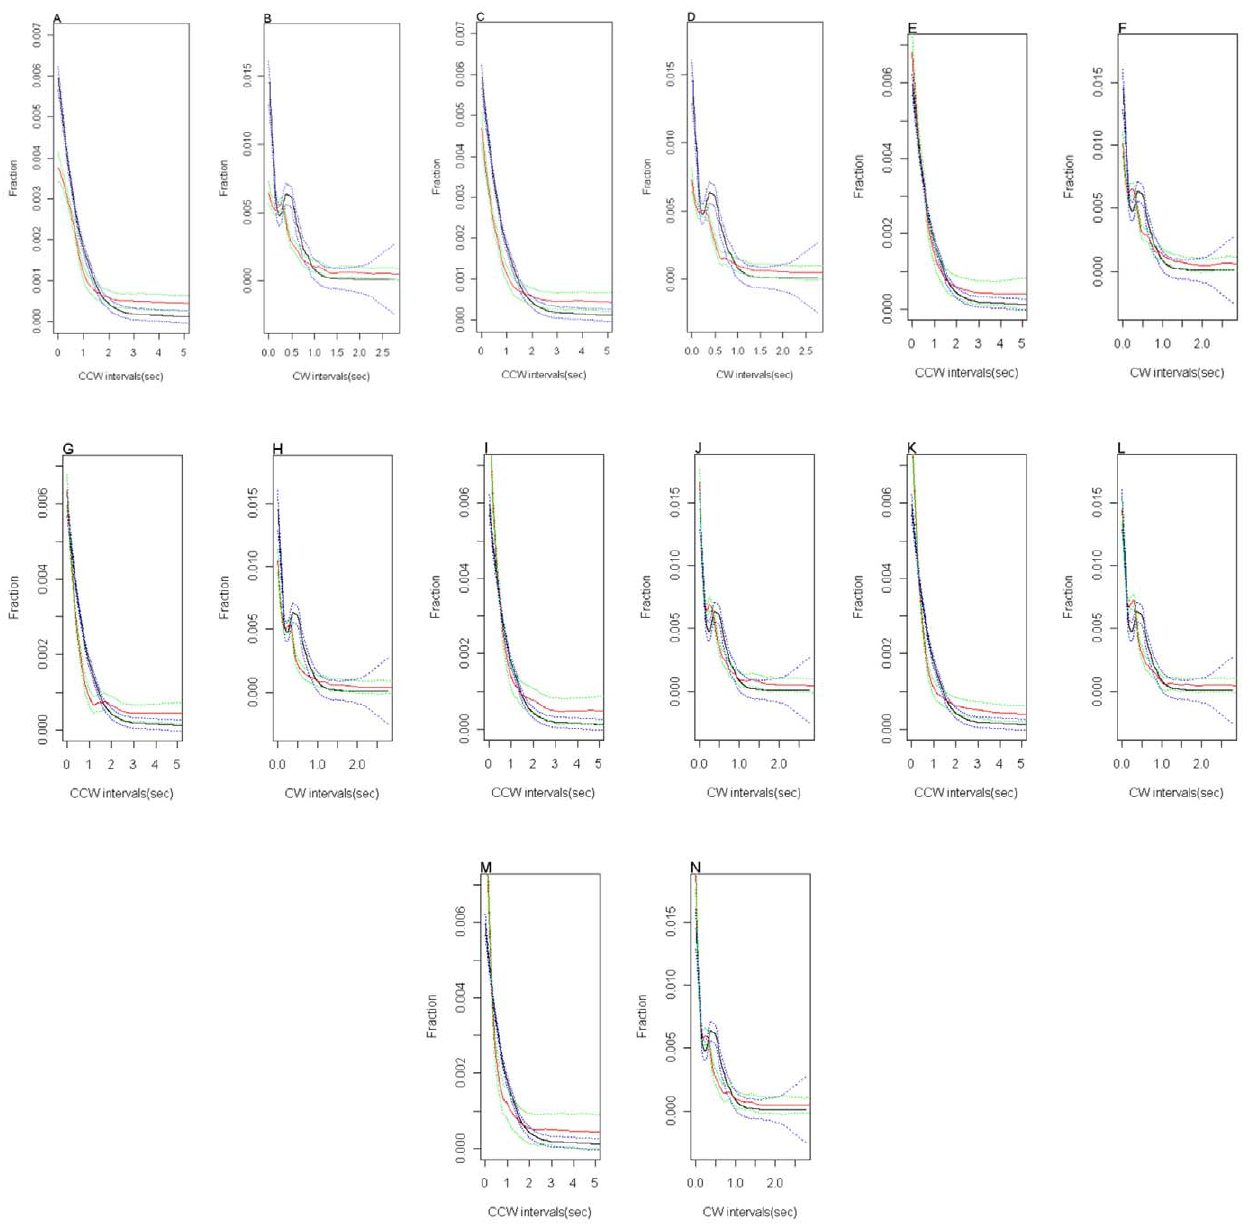
Figure 5. The LOESS fitting of the clockwise and counter-clockwise distributions that achieved equilibrium. The letters correspond to the simulations given in table 2.